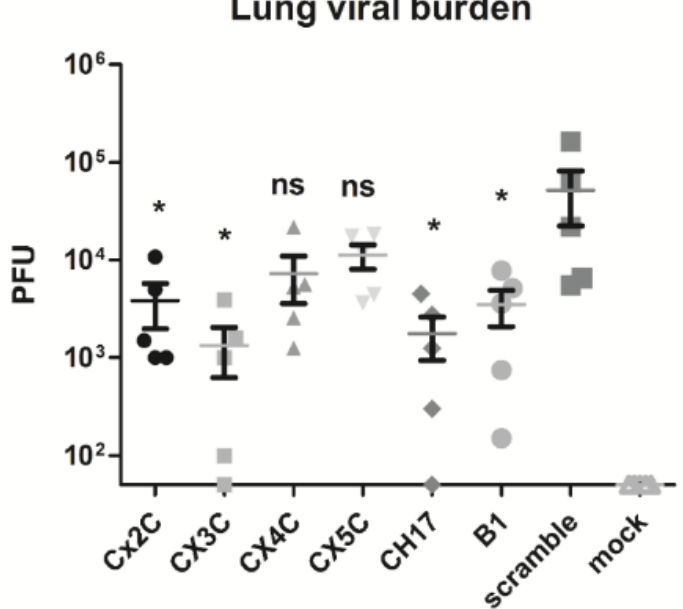
Figure 4. Lung virus titers following RSV challenge of mice vaccinated with peptides. Mice were vaccinated subcutaneously (s.c) with CXC3 peptides or scramble control peptide, challenged i.n. with 10 6 PFU RSV A2, and lung virus titers were determined at day 5 post-challenge. Lung virus titers were determined by immunostaining plaque assay. Data are presented as total PFU/whole lung tissue. Experiments were independently repeated at least 3 times and analyzed by one-way ANOVA test. Values shown as the mean ± SEM; * p < 0.05 vs . scramble